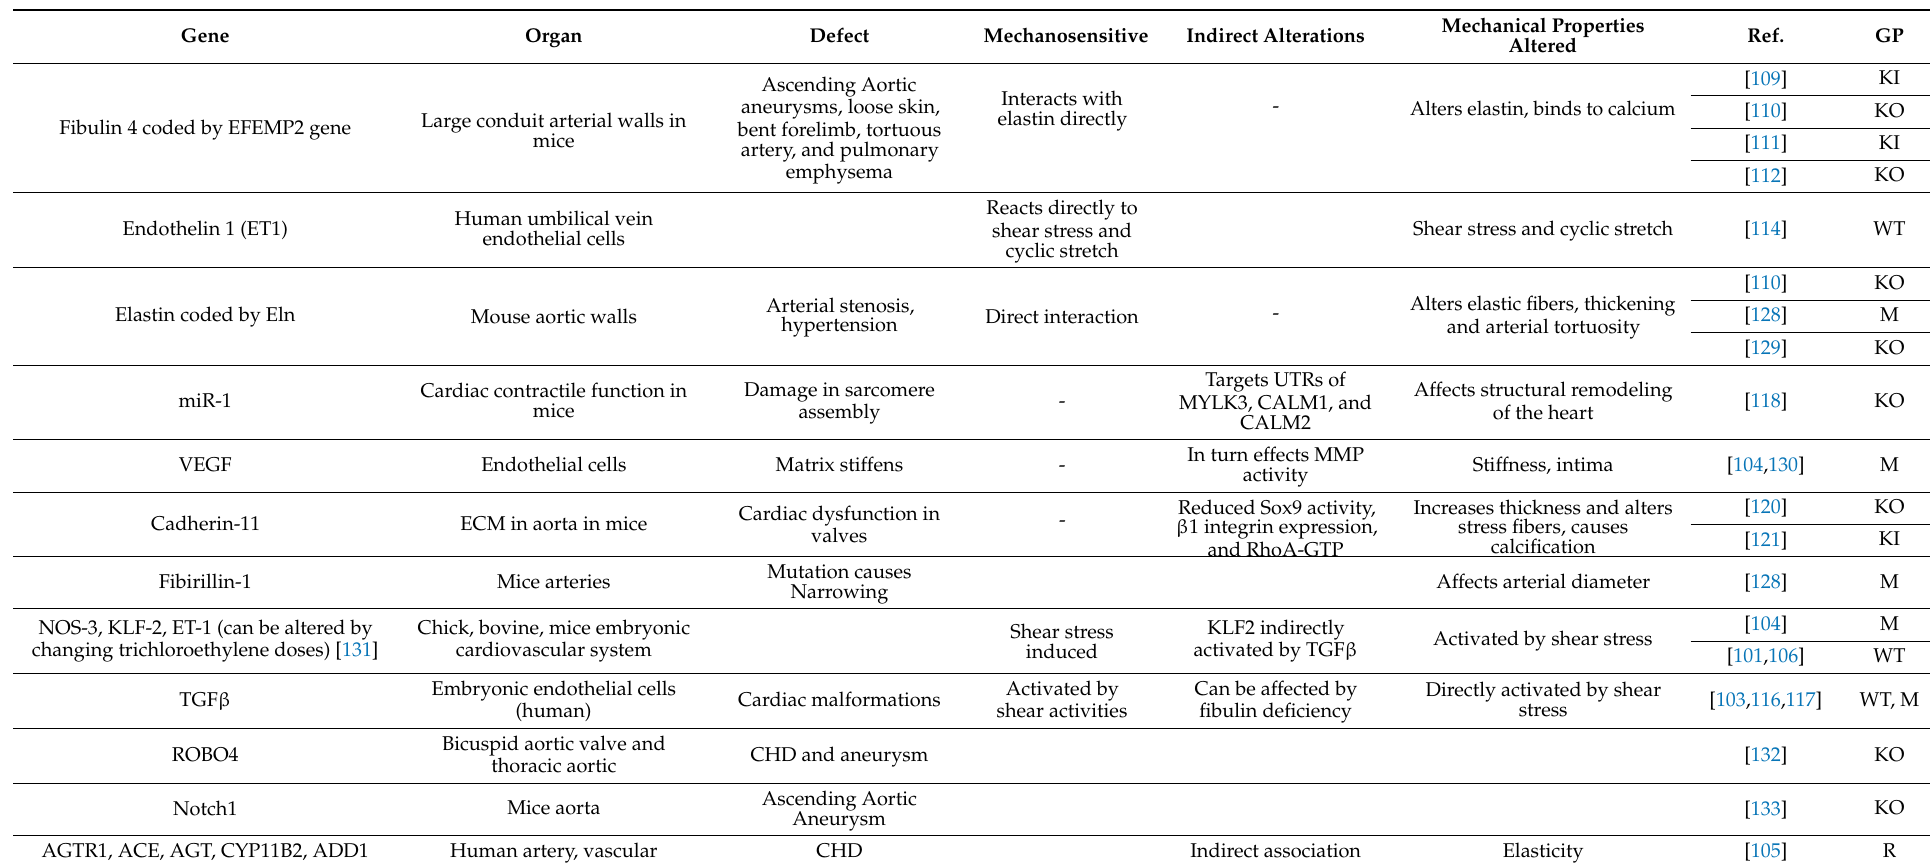
Table 7. Mechanical property phenotypes and the response of mechanosensitive genes that play a critical role in structural cardiovascular development are summarized. Mechanosensitive genes are activated as a response to mechanical changes, while mechanoresponsive genes cause a mechanical change in the